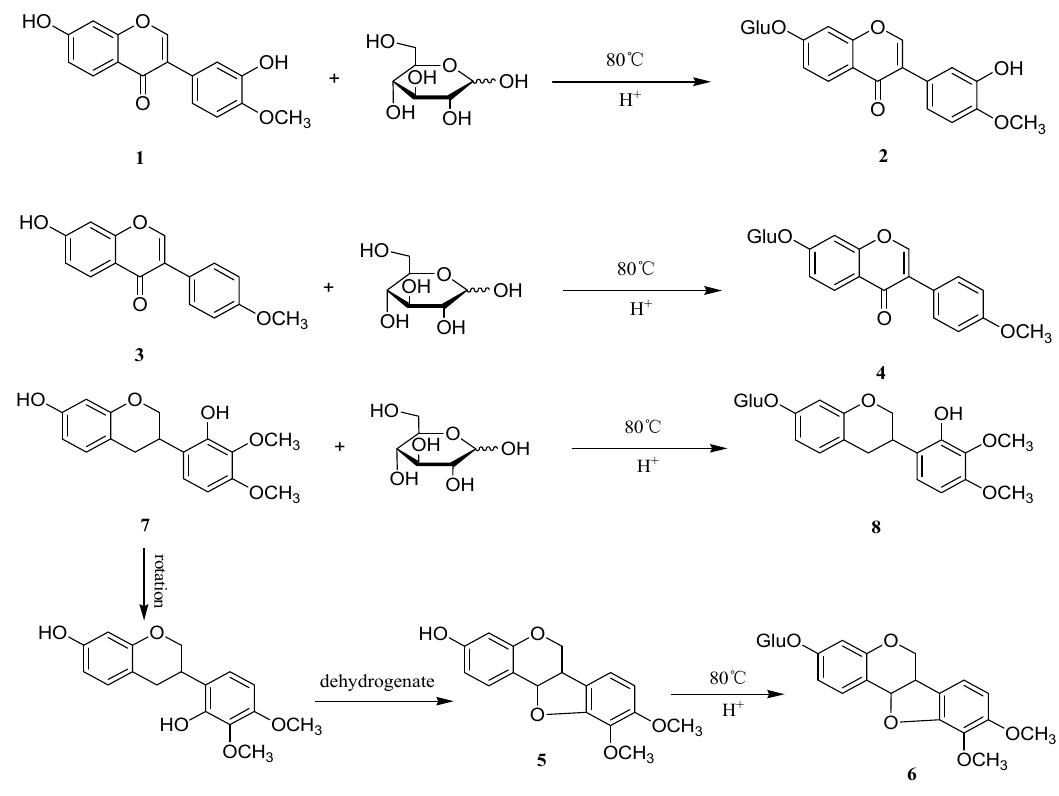
Figure 3. The synthesis of flavonoid glycosides.